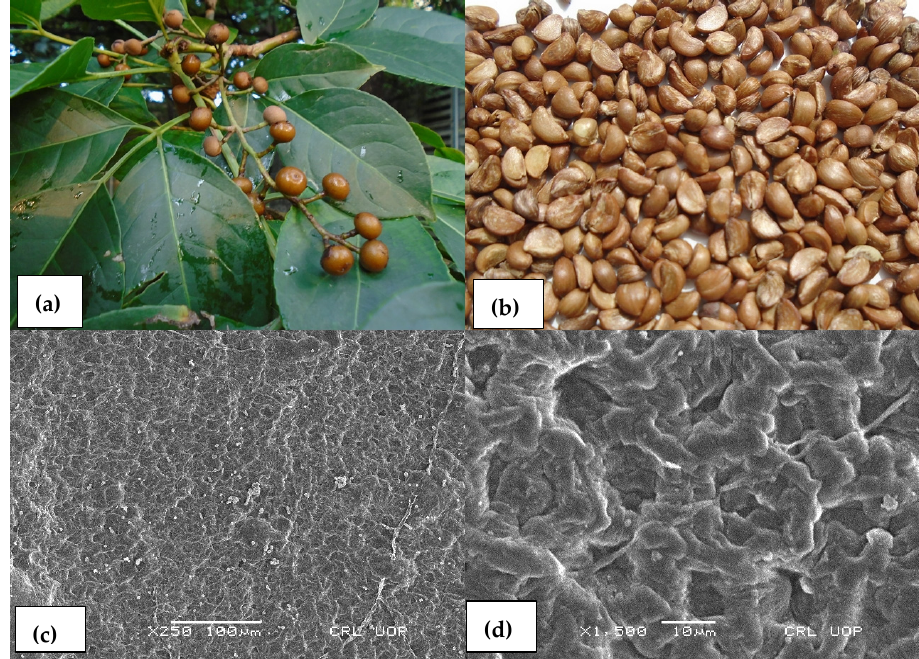
Figure 2. Bischofia javanica ( a ) plant, ( b ) seeds, and ( c , d ) SEM micrograph of the seed sculpturing.